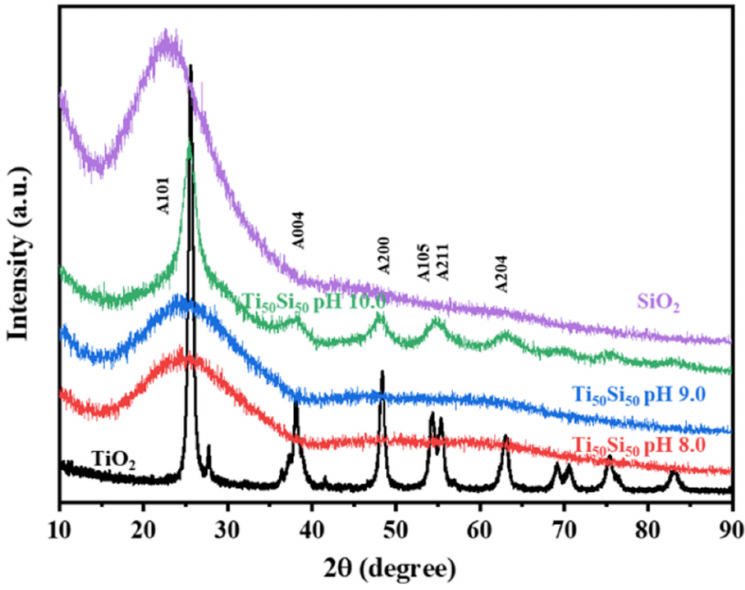
Figure 9. XRD patterns of Ti 50 Si 50 oxide synthesized with pH 8.0, 9.0, and